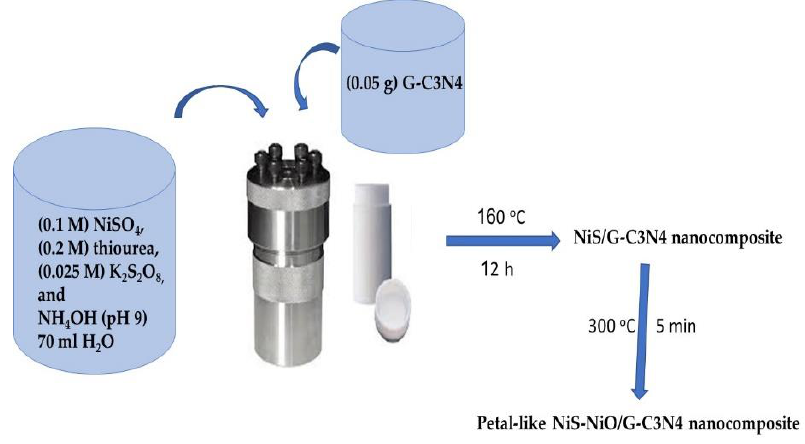
Figure 1. The schematic preparation for the Petal-like NiS-NiO/G-C3N4 nanocomposite.